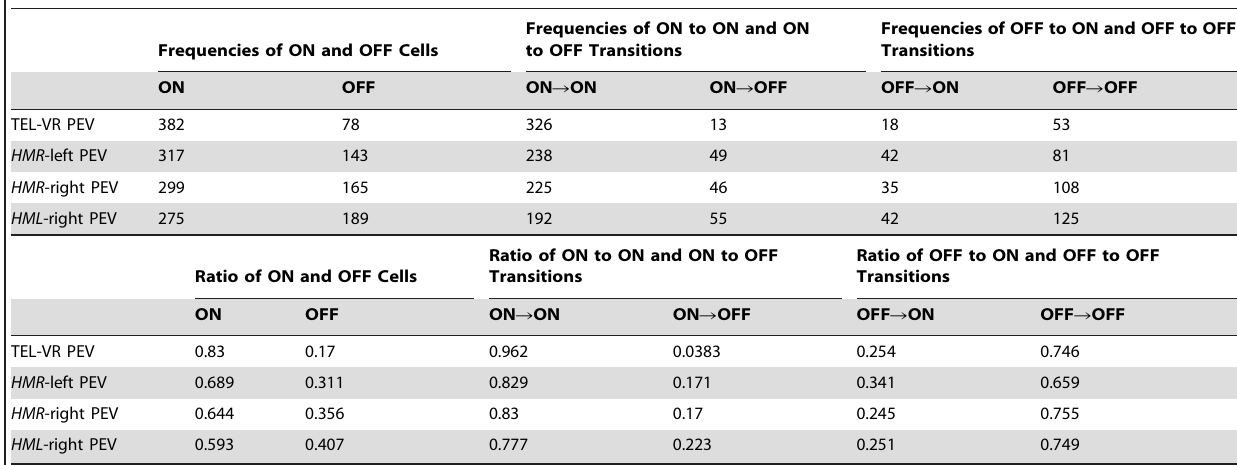
Table 1. Statistical test for state-transition at Telomere and HM region.